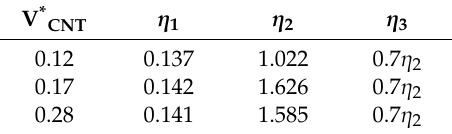
Table 6. Carbon nanotube (CNT) e ffi ciency parameters with respect to various volume fractions. V *